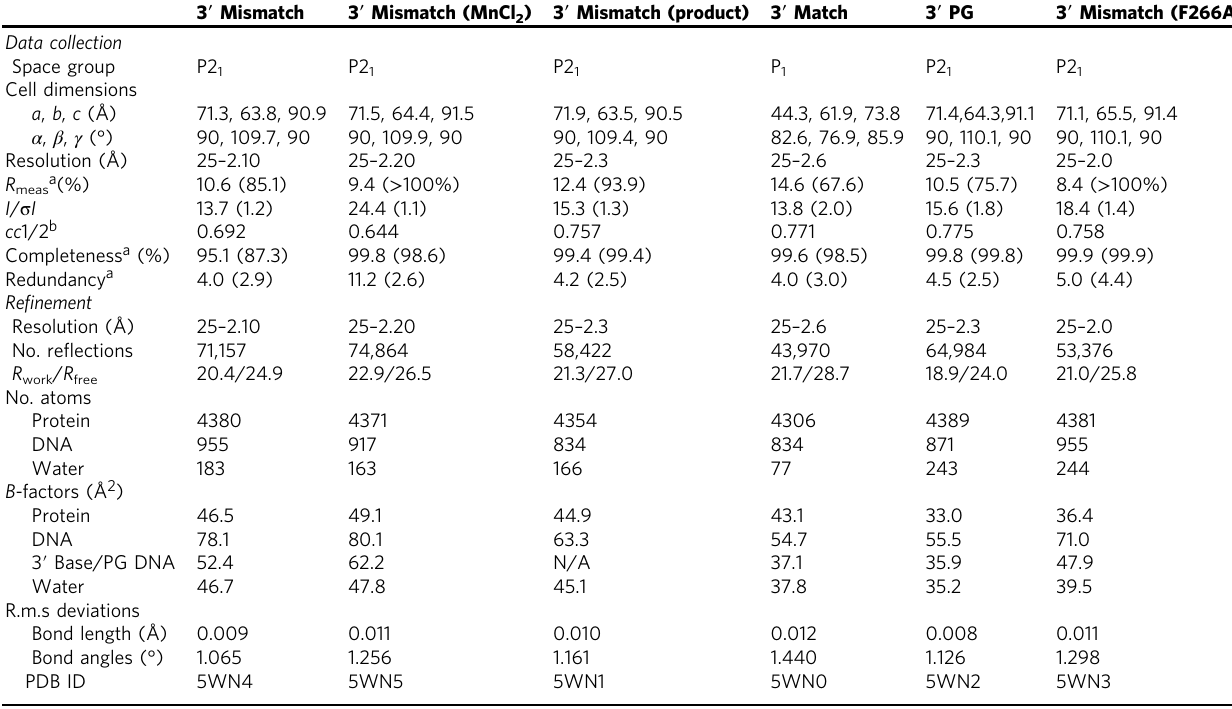
a Highest resolution shell is shown in parentheses. b For highest resolution